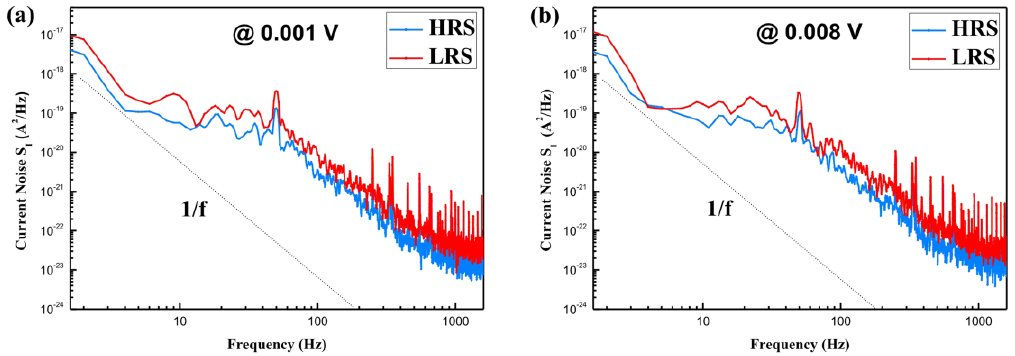
Figure 8. Current noise power spectral density of the Al/ Bombyx mori body fluid film/ITO biomemristor in the LRS and the HRS under applied voltages of ( a ) 0.001 V and ( b ) 0.008 V. Bombyx mori body fluid is a circulating liquid that bathes all tissues and organs in the body